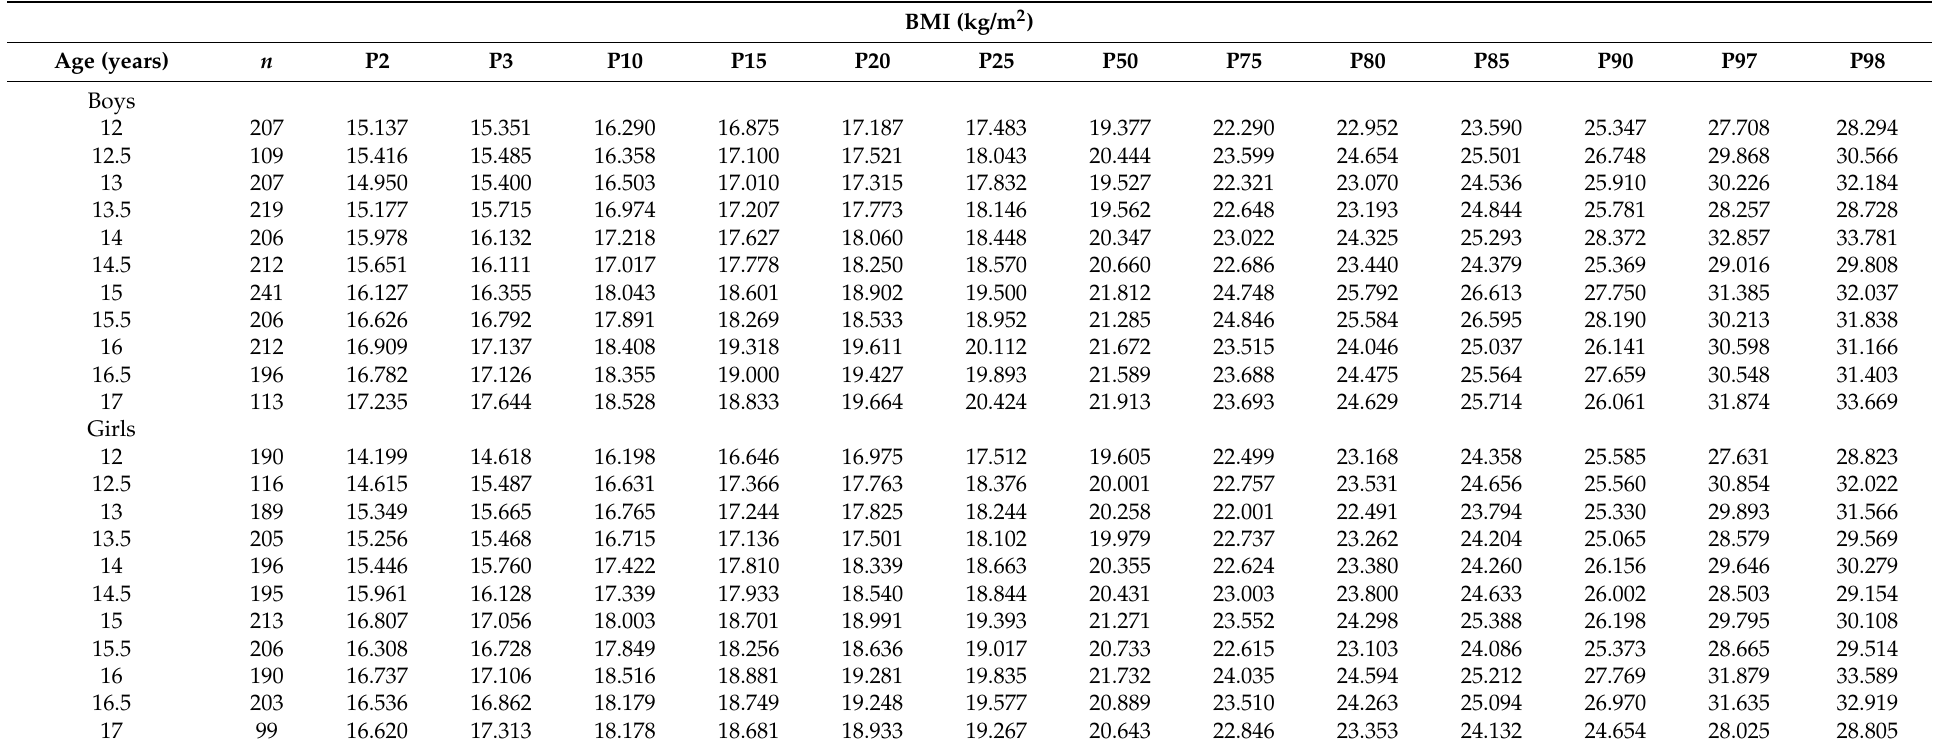
Table 6. Percentile distribution outcomes of BMI by gender and